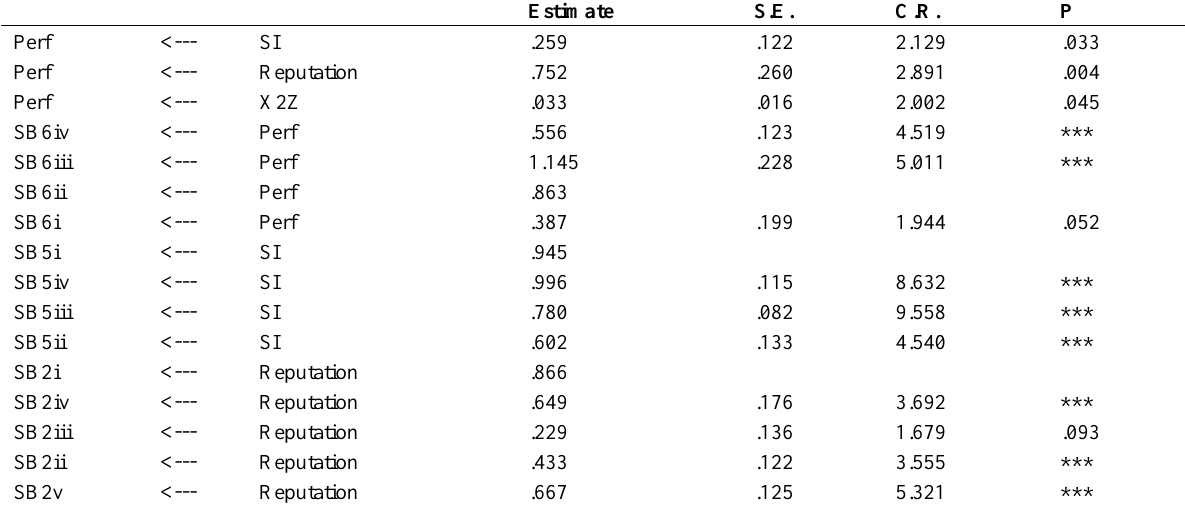
Table 6: Regression Weights for the Moderating Effect of Service innovation on Reputation and Performance of Hotels in